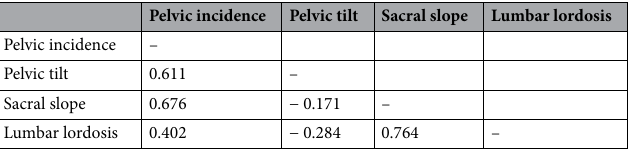
Table 3. Correlation coefficient of each item derived from the univariate